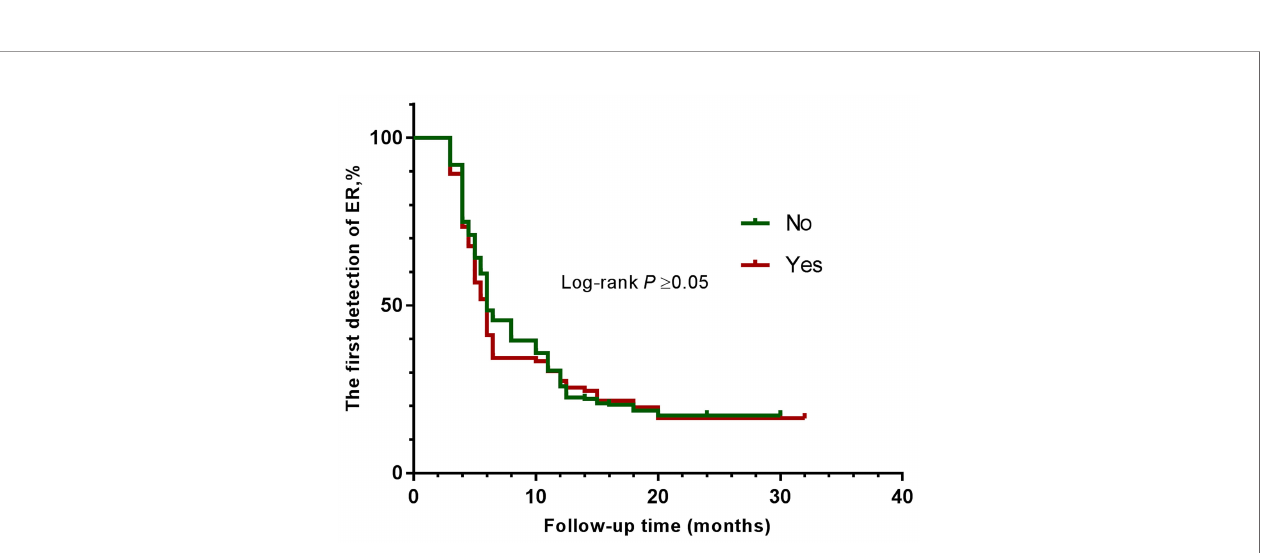
FIGURE 1 | Kaplan-Meier curves show the results of the fi rst detection of ER in patients with PTC. The patients were divided into four groups — underweight (blue line), normal weight (green line), overweight (orange line), and obese (brown line).